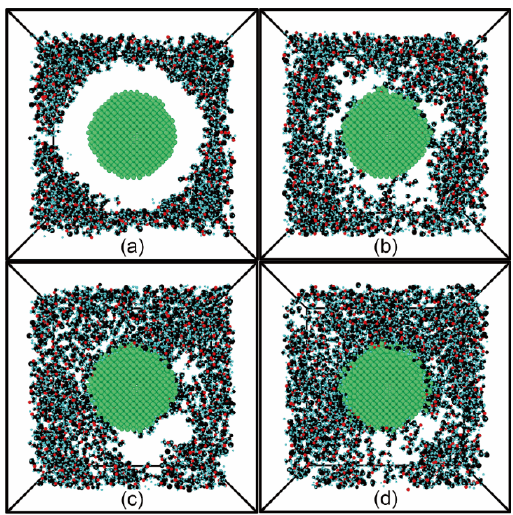
Figure 5. Snapshots of single sphere model at ( a ) 0 ps, ( b ) 8 ps, ( c ) 16 ps and ( d ) 24 ps.